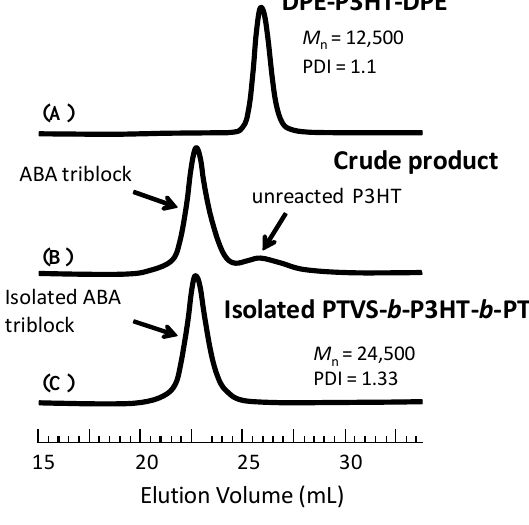
Figure 2. SEC RI traces of ( A ) DPE-P3HT-DPE, ( B ) the crude product, and ( C ) the isolated PTVS- b -P3HT- b